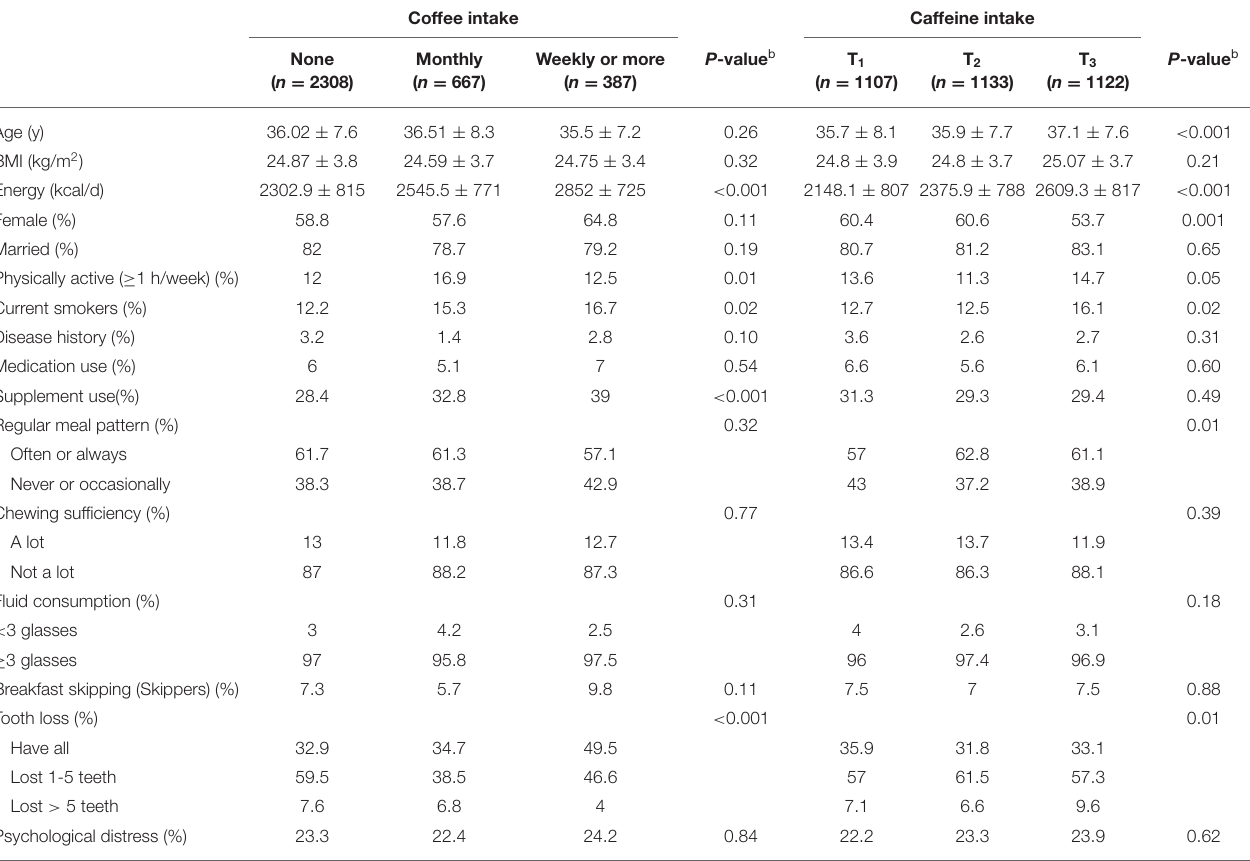
TABLE 1 | General characteristics of study participants across categories of coffee and caffeine intake a